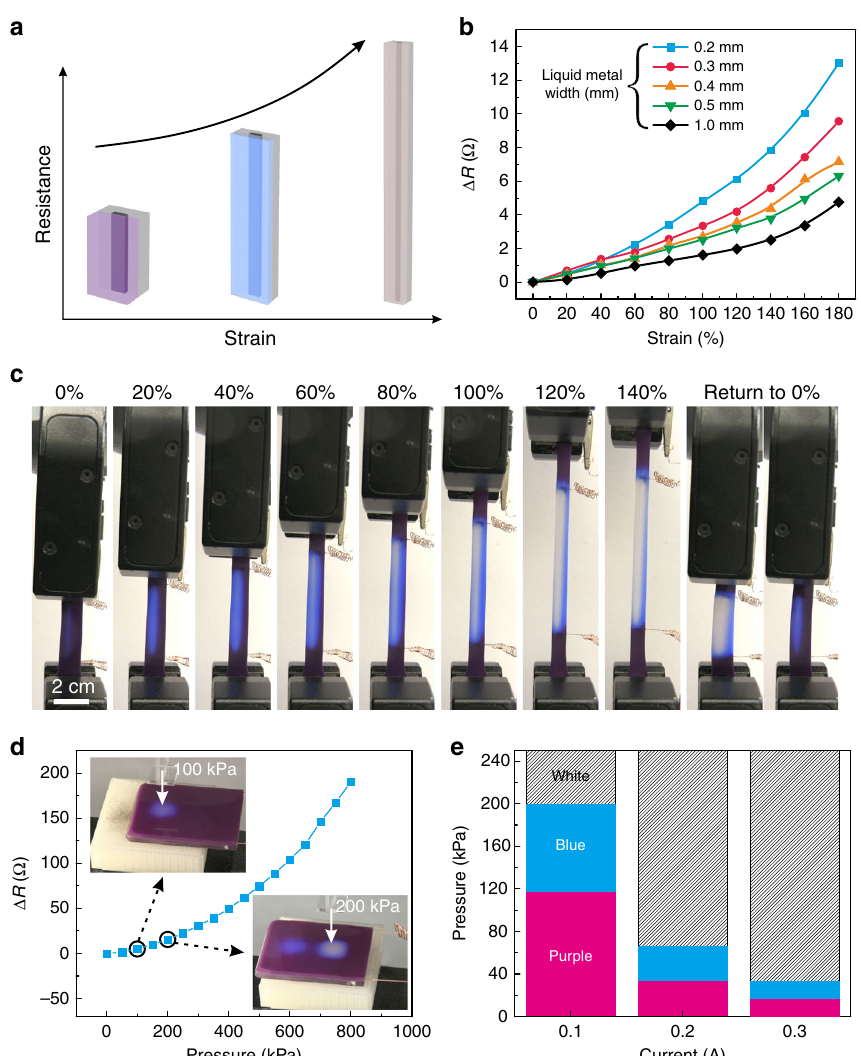
Fig. 2 Thermomechanochromism effects and tactile sensing. a Stretching a liquid metal wire causes the geometry of the wires to change, and thus, the resistance and the current density increase. These changes increase Joule heating, resulting in a color change. b Change in resistance as a function of strain. Δ R is the resistance at a given strain minus the resistance at 0% strain. c Photographs of a device being stretched while maintaining constant current (but increased current density). d Change in resistance as a function of pressure through a single serpentine conductor. Inset images show the color change in response to different pressures (100 and 200 kPa). e The color response depends on the current and pressure for a 1 mm width